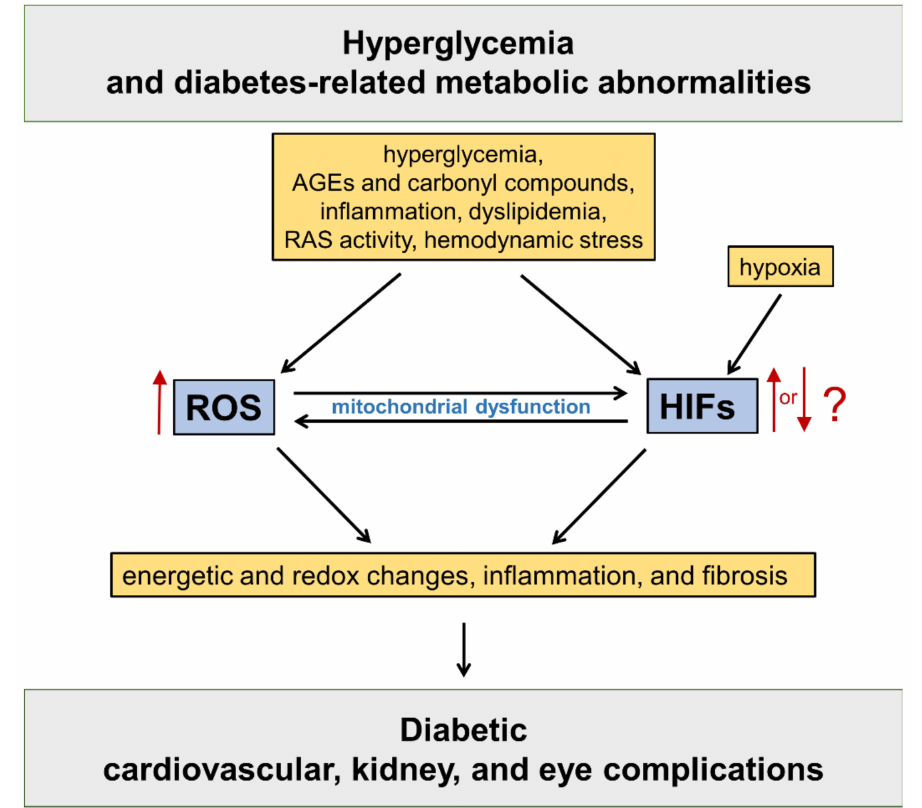
Figure 1. Oxidative stress and hypoxia-inducible factors (HIFs) in the pathogenesis of diabetic vascular complications. Refer to the main text for detailed description. AGEs = advanced glycation end products; RAS = renin angiotensin system; ROS = reactive oxygen